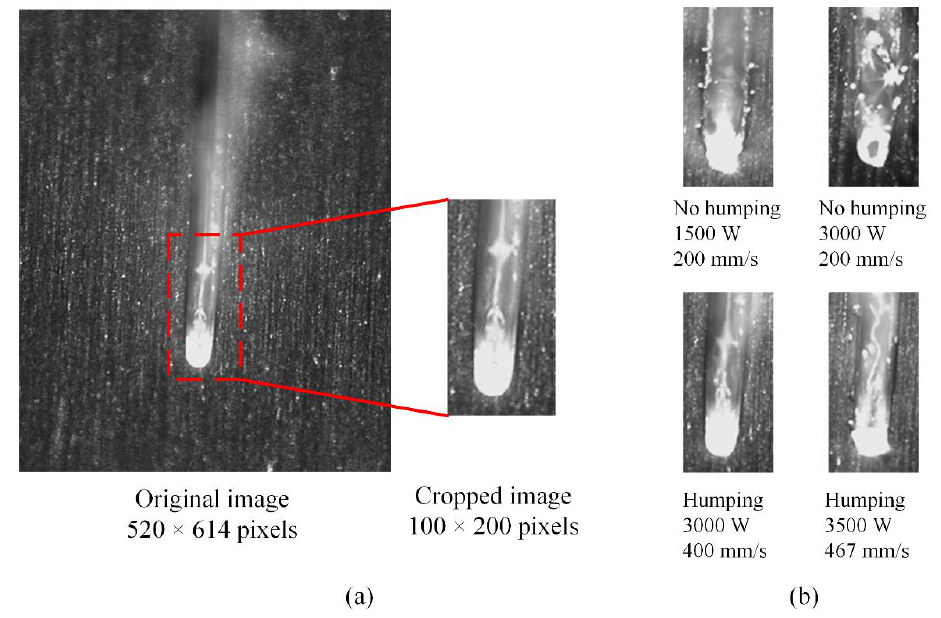
Figure 6. Image cropping. ( a ) Illustration of the cropping process. ( b ) Examples of the cropped images.